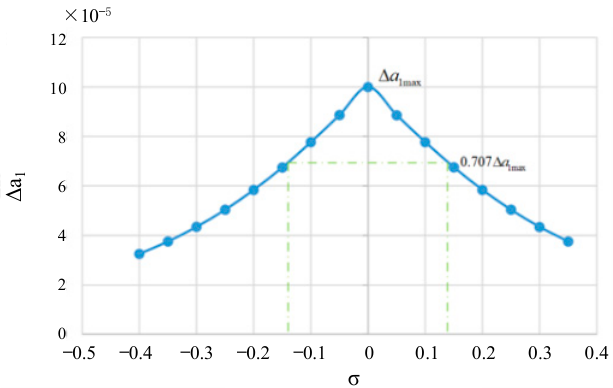
Figure 8. Influence of σ on energy transfer.